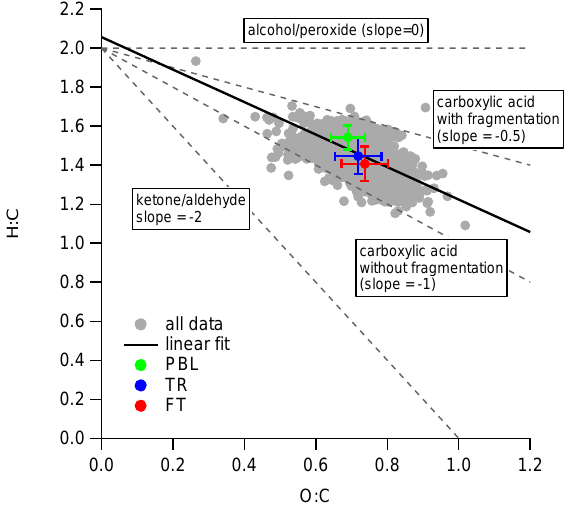
Figure 5. Van Krevelen diagram presenting the H:C and O:C ra- tios of all the data points collected during the campaign, together with average values for PBL, TR and FT samples. The solid line represents the fit to the data (not constrained to H:C = 2). Dashed lines describes oxidation reactions occurring through addition of carbonyl groups (slope = − 2; Heald et al., 2010), carboxylic acid without fragmentation (slope = − 1; Heald et al., 2010), carboxylic acid with fragmentation (slope = − 0 . 5; Ng et al., 2011) and alco- hol/peroxide (slope = 0; Heald et al., 2010).